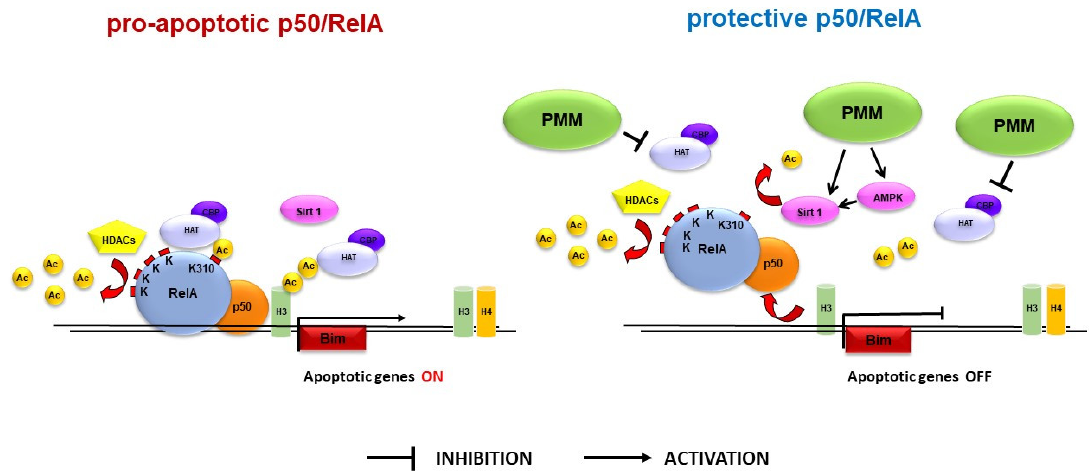
Figure 5. PMM-mediated defense from ischemic injury. During OGD, the activated RelA within the p50/RelA dimer is in its aberrantly acetylated form, consisting of a hypoacetylated state with the exception of the residue K310. In this condition, p50/RelA binds the pro-apoptotic Bim promoter, an event followed by specific histone H3 acetylation at the target gene promoter. We demonstrated that the pre-treatment of neurons with PMM was able to limit the RelA(K310) acetylation and the H3 acetylation at the Bim promoter. Neither the general acetylation of RelA, nor the general histone acetylation, were restored by the supplement mixture, suggesting that PMM acts as a histone acetyltransferase (HAT) inhibitor, rather than a histone deacetylase (HDAC) inhibitor. We speculate that the correction of the aberrant RelA acetylation in K310 could be promoted by components of the mixture able to act as HAT inhibitors, including EGCG, quercetin and LA. Also, the activation of the AMPK–sirtuin 1 pathway by EGCG, quercetin, LA, vitamin C, vitamin E, vitamin B6 and N-acetyl-L-